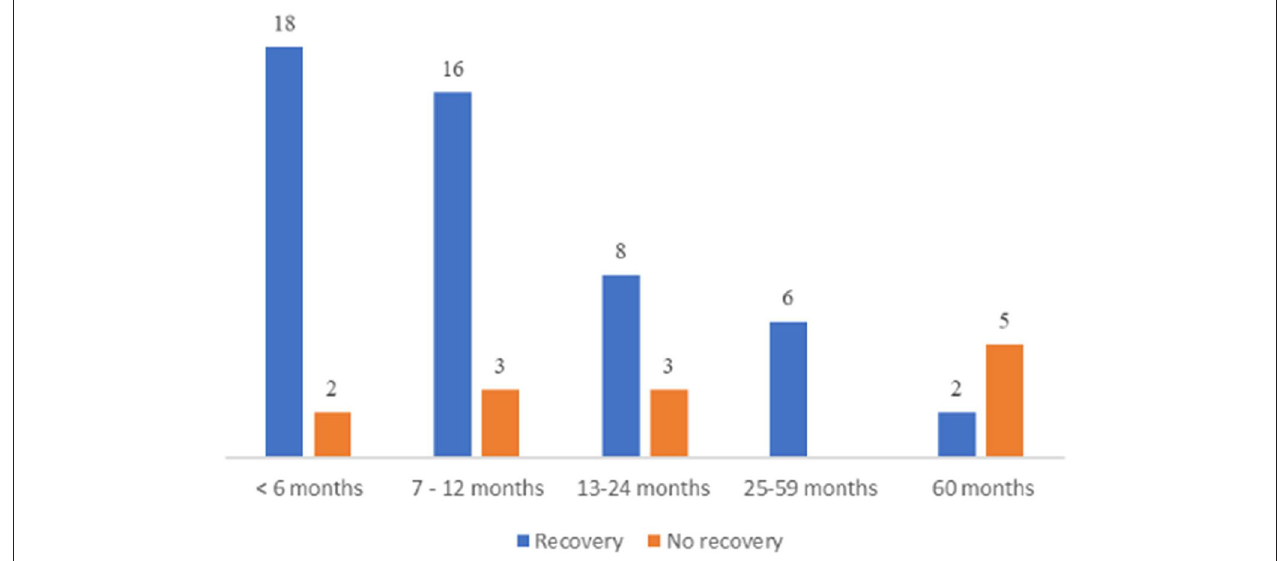
FIGURE 3 | Age at onset. Summary of the outcome in the different age groups with total number of patients for each segment.